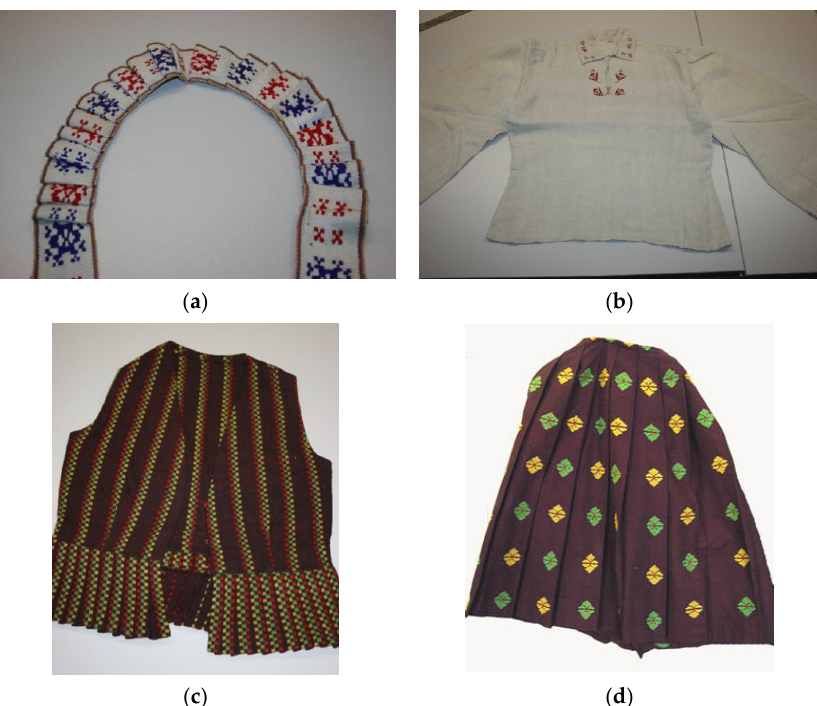
Figure 18. National costume from Dzūkija (from Varėna district): ( a ) Ribbon wrapped for the crown ČDM E3859e; ( b ) shirt ČDM E3859c; ( c ) vest ČDM E3859b; ( d ) skirt ČDM E3859a. Clothes of Suvalkija were especially gorgeous. The most attention-grabbing elements are the overlaid aprons, in which stylised lily flowers, peas, and other flowers glow in the colours of the rainbow. The white and red vertically striped aprons from the Zanavykai region are earlier than the overlaid varieties. The patterns of such aprons are similar to those in Lithuania Minor. Shirts embroidered with perforations in white were popular in the whole of Suvalkija, and their most distinctive feature is wide sleeves. They are also embroidered with cross-stitching, and red and greenish-brown threaded shirts (charac- teristic of Kapsai) were worn. These are available with loose sleeves or without cuffs, and the embroidered patterns reach almost to the elbows. Vests of Kapsai are long, intricately sewn, and very widely distributed at the bottom, whole those of Zanavykai are short. Both have vests with a concave rectangle on the front. Vertically striped skirts, in which wide